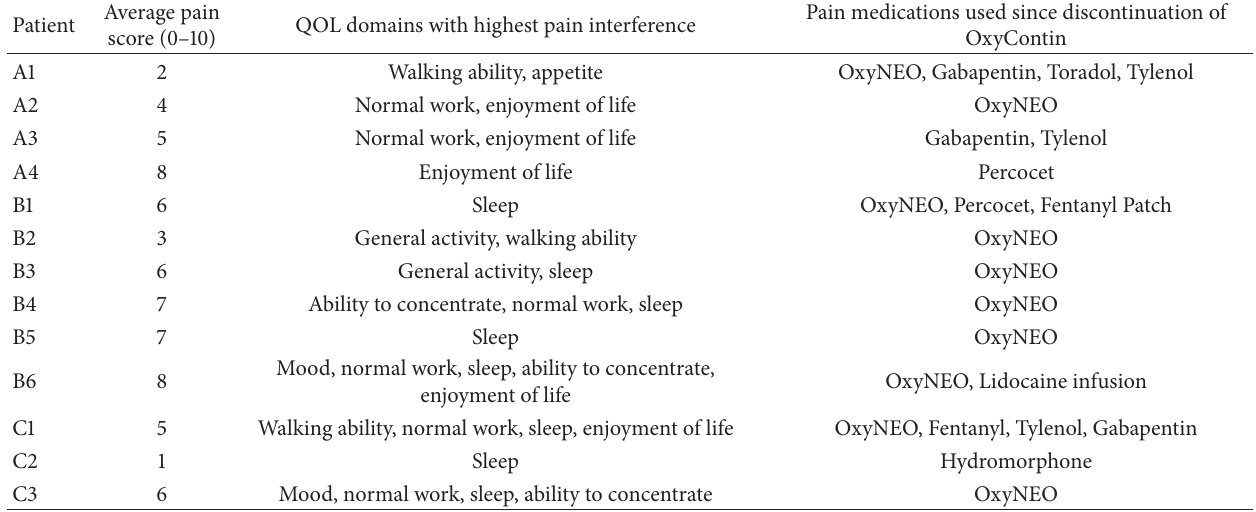
Table 2: Findings from the Brief Pain Inventory